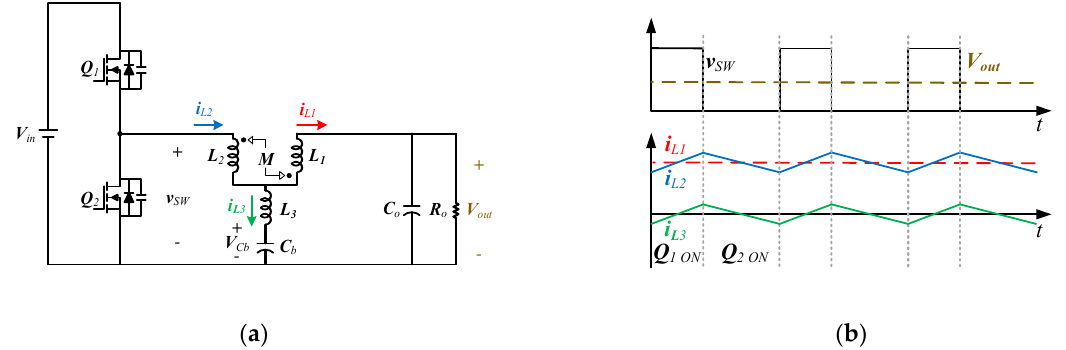
Figure 2. LL-LC circuit: ( a ) circuit architecture diagram; ( b ) operation sequence diagram.